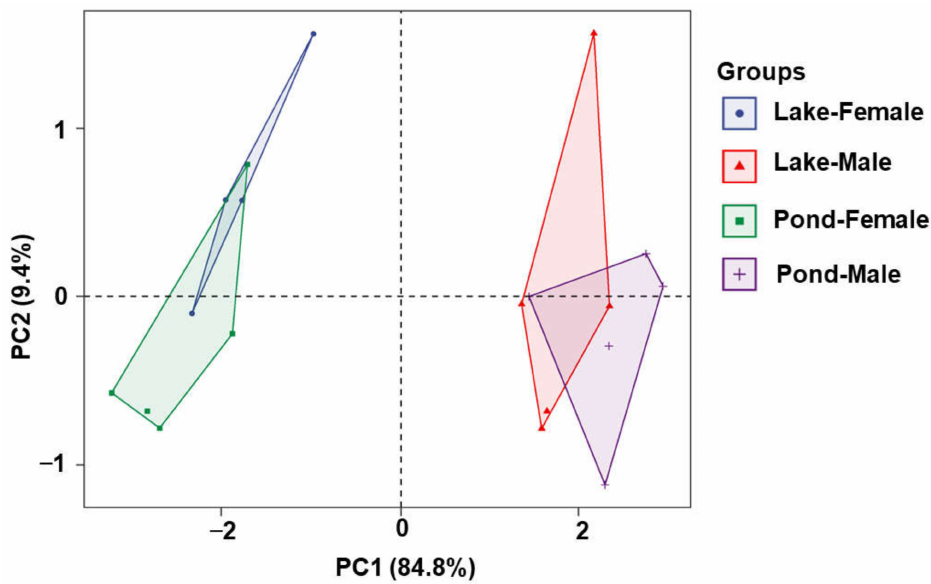
Figure 2. PCA of the taste values of umami, aftertaste-U, bitterness, aftertaste-B, astringency, and aftertaste-A in the hepatopancreas of June hairy crabs.